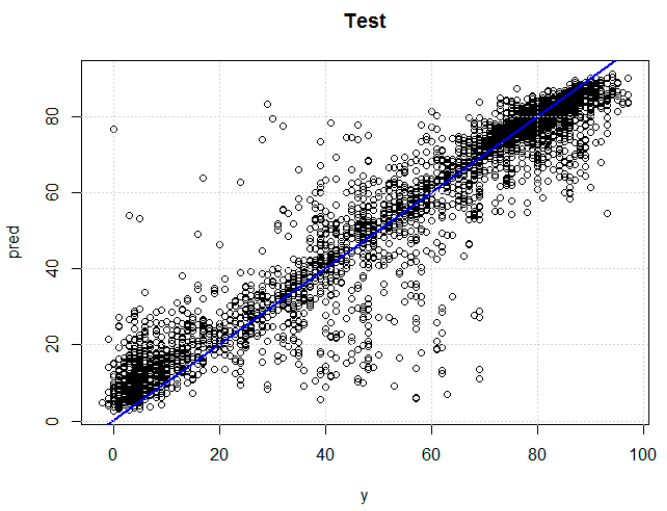
Figure 6. Point cloud (test) Random Forest. Table 6. Importance of the